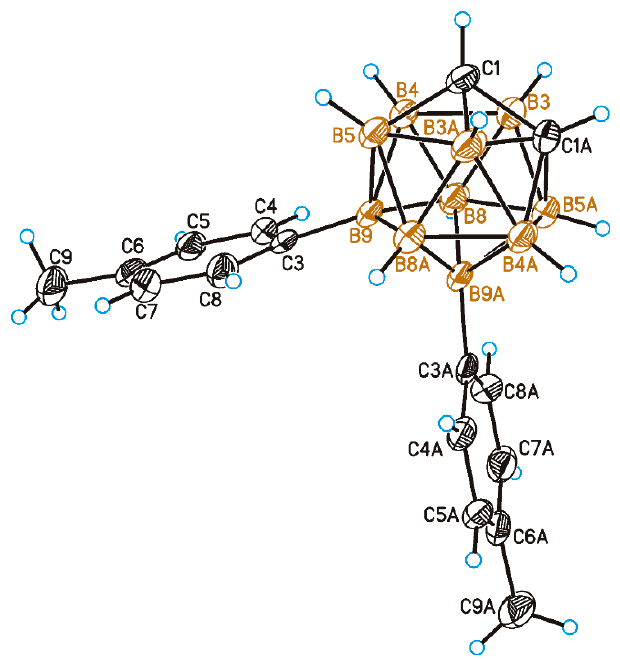
Figure 4. General view of 9,12-( p -MeC 6 H 4 ) 2 -1,2-C 2 B 10 H 11 ( 14 ) showing atomic numbering. Thermal ellipsoids are drawn at 50% probability level. The molecule occupies special position. Numbering of symmetrically dependent part are marked with letter “A”.